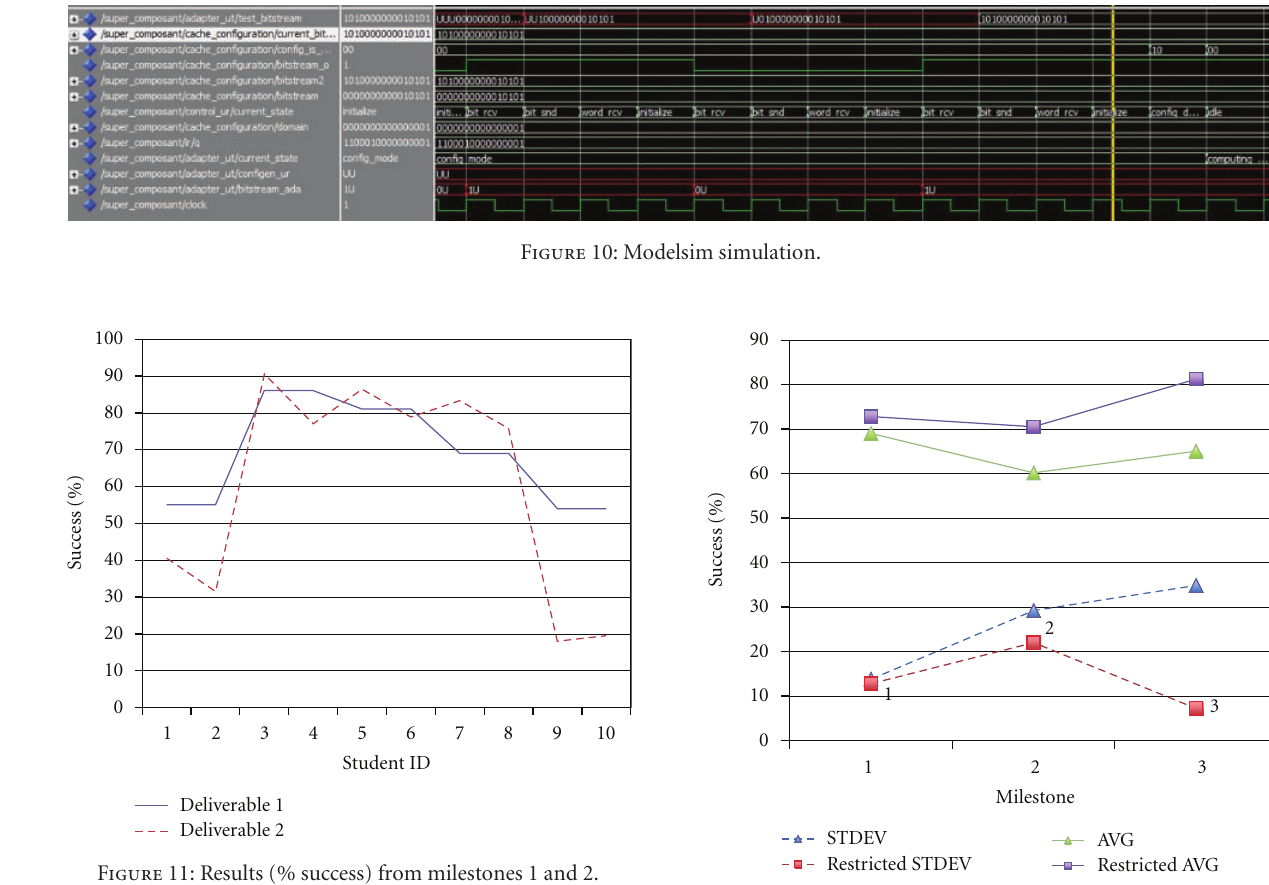
Figure 12: Global